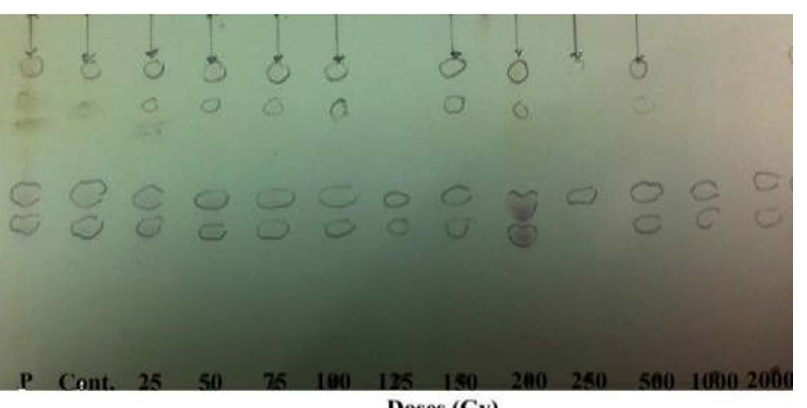
Fig. 3. Analytical TLC image of various doses of gamma ray samples of penicillin extracted from P.chrysogenum Table 3. Production of penicillin by wild-type and mutant strains of P. chrysogenum Doses Concentration Percentage